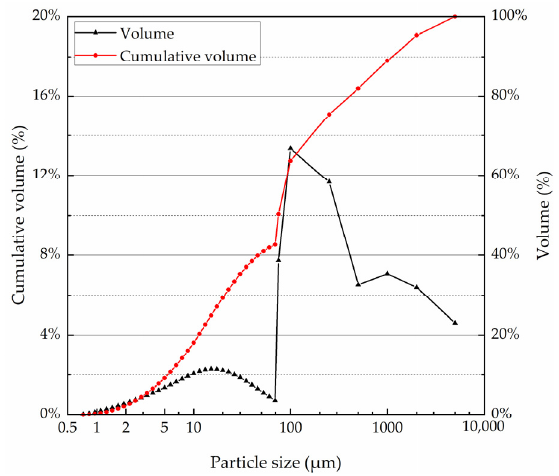
Figure 1. Particle size distribution of the CLS. Table 1. Physical properties of the CLS.